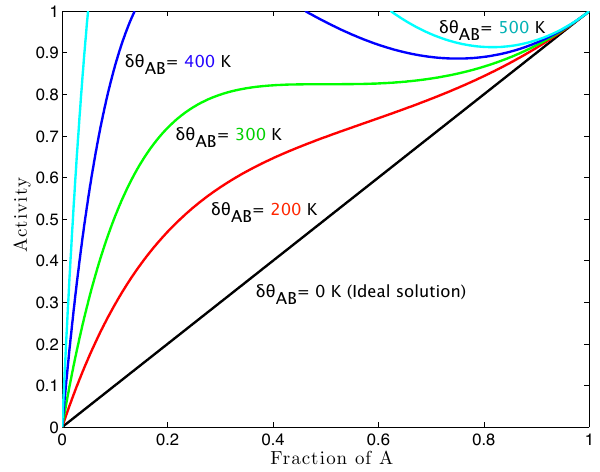
Fig. A2. Activity of component A at 300 K for two-component ( A - B ) mixtures with non-ideal interaction energies δθ A,B of 200, 300, 400, and 500 K. For δθ > 300 the system rapidly phase separates, quickly achieving almost complete